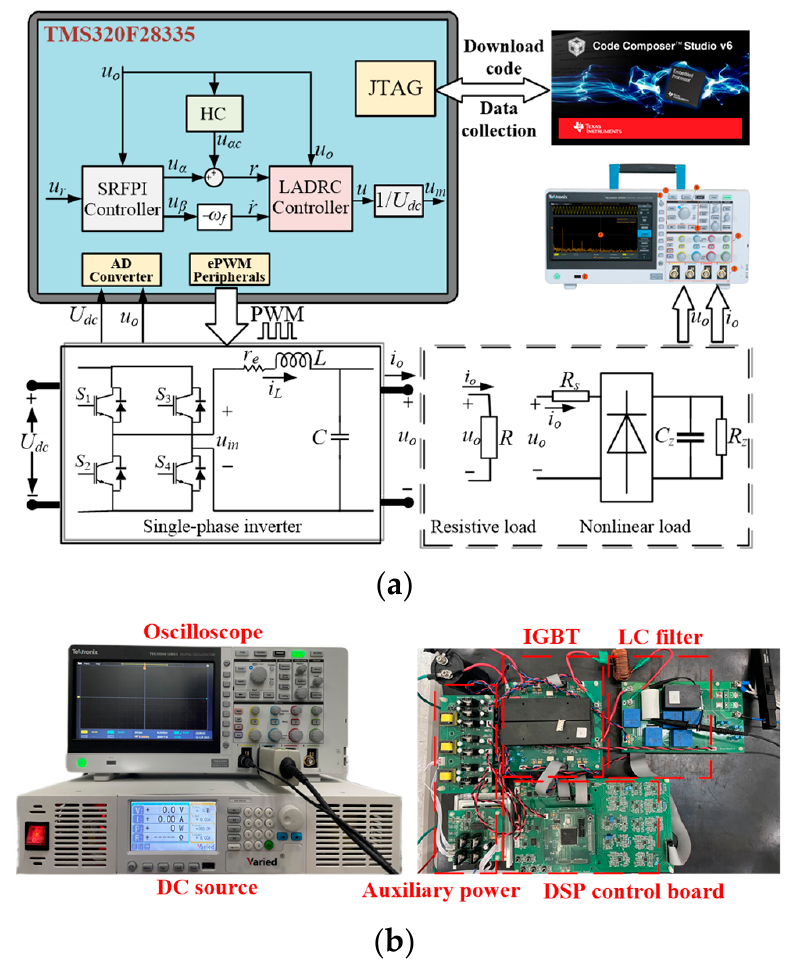
Figure 13. ( a ) Block diagram of the overall system. ( b ) Experimental platform.